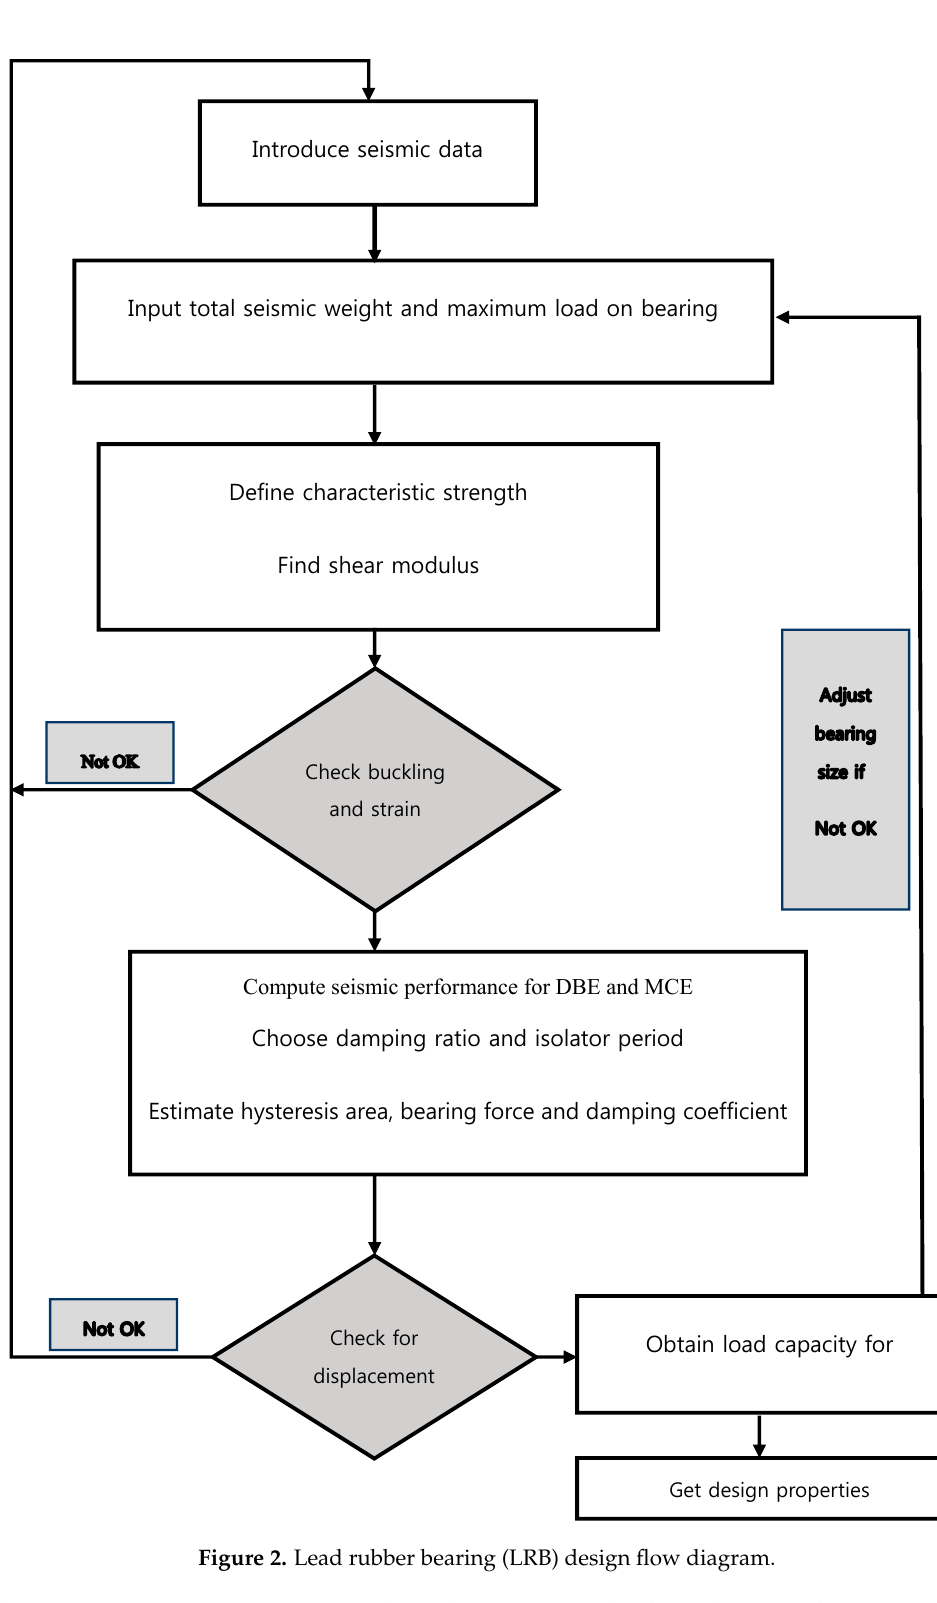
Figure 2. Lead rubber bearing (LRB) design flow Figure 2 Lead rubber bearing (LRB) design flow diagram.